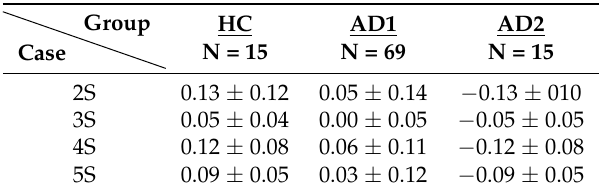
Table 4. Comparison of MSE-based weighted sum values among the HC, AD1, and AD2 groups. (The values are labeled as mean ± SD.)